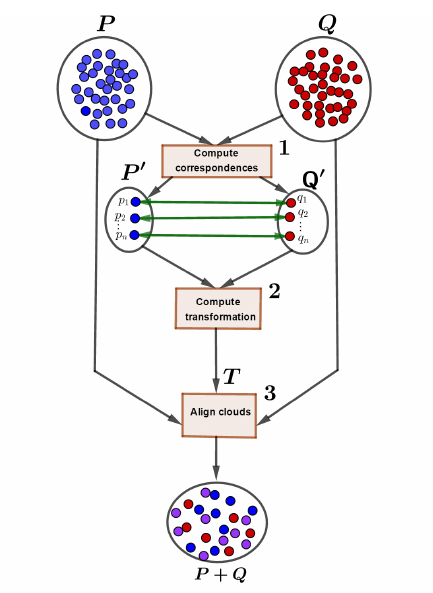
Figure 1. General approach to point cloud registration: let P and Q be two sets of overlapping points in two different spaces. P and Q are aligned in the same space using the following steps: 1—find two sets of corresponding points P (cid:48) and Q (cid:48) in P and Q respectively; 2—compute the transformation T such that T ( P (cid:48) ) = Q (cid:48) ; 3—use T to align P and Q (apply T ( P )